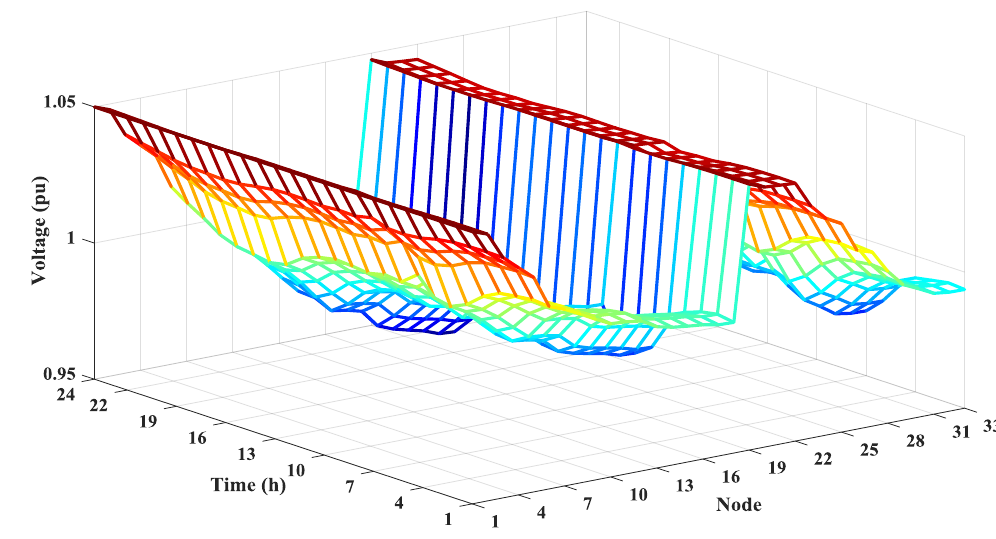
Figure 9. Power loss of the distribution network.